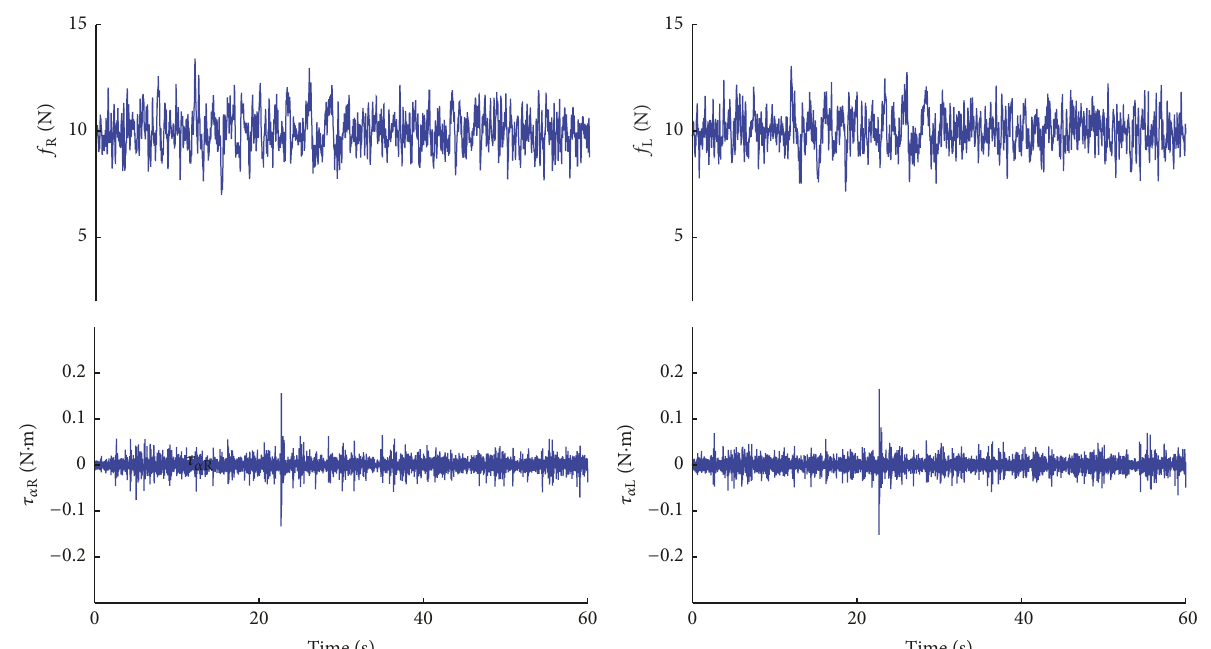
Figure 11: Applied thrusts and torques to the tilt-rotor UAV by the propellers and servomotors,